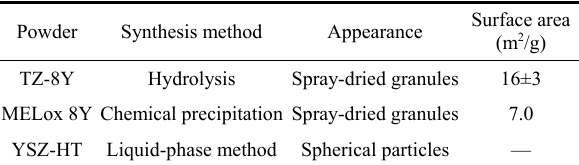
Table 1 Synthesis methods and characteristics of the YSZ powders used in this work Powder Synthesis